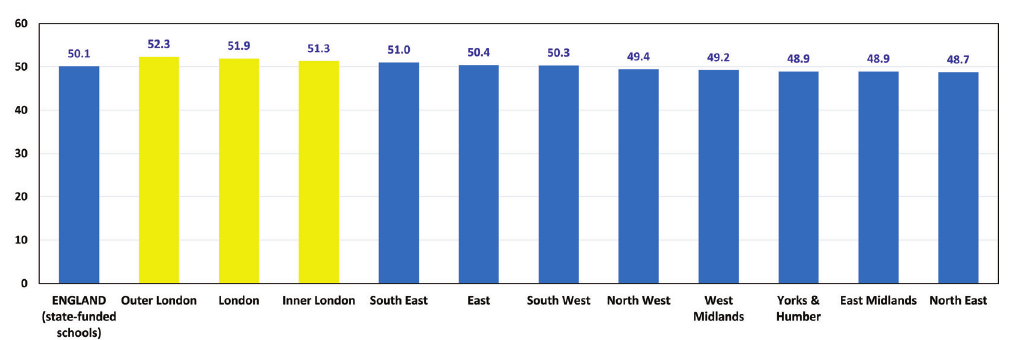
Figure 6: Average Attainment 8 score by region at Key Stage 4 in